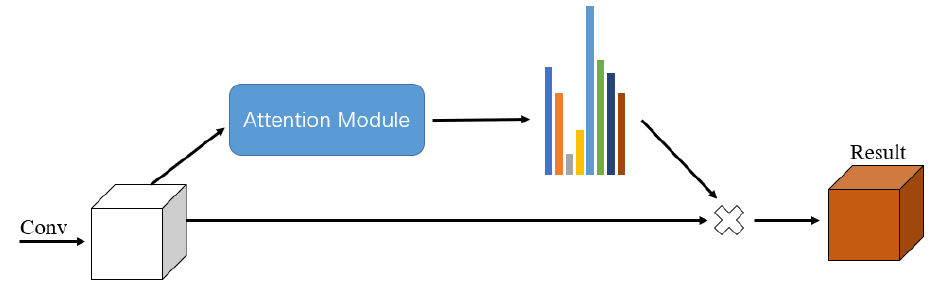
Figure 1. Generalized structure of an a tt ention mechanism.